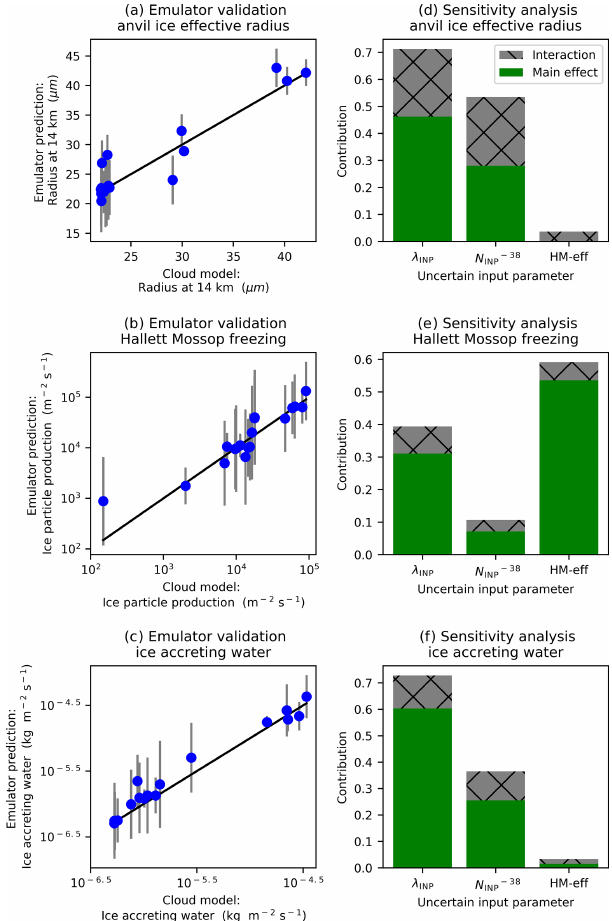
Figure 11. Emulator validation and uncertain input contributions to output uncertainty. Validation of emulator results (a–c) and results of the variance-based sensitivity analysis (d–f) for anvil effective ra- dius at 14km (a, b) , ice particle production by the Hallett–Mossop process (c, d) , and water accretion by ice (e, f) . In panels (a) – (c) the dots show the value of the validation run on the x axis and the cor- responding emulator mean prediction on the y axis. The 95% con- fidence intervals of the emulator mean predictions are also shown. An emulator that validates well will have dots close to the 1 : 1 line and small error bars. Panels (a) and (d) are the average of the cloud property between 150 and 240min (anvil stage) of the simulation, while panels (b) , (c) , (e) , and (f) are the average of the relevant cloud property between 60 and 180min (convective stage) of the